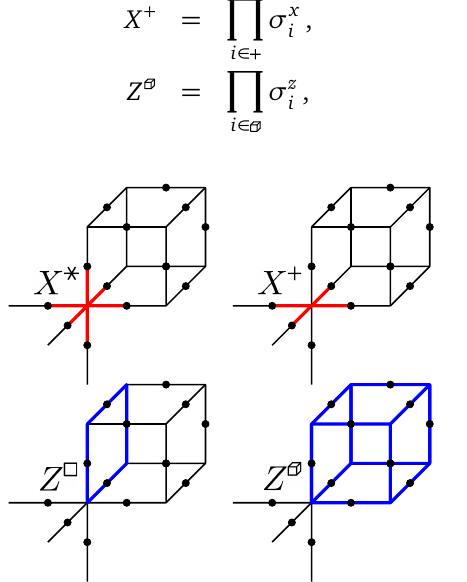
Figure 1: Illustration of the four operators on the cubic lattice which are contained in . Left : Operators X and Z of the TC. Right : Operators X and Z of the H XC. Note that we show only one of three possible orientations of the X and Z operators. Red (blue) operators are multi-spin interactions built by σ x matrices. Here i denotes the links of the cubic lattice and the spin-1 / 2 degrees of freedom are indicated by filled black